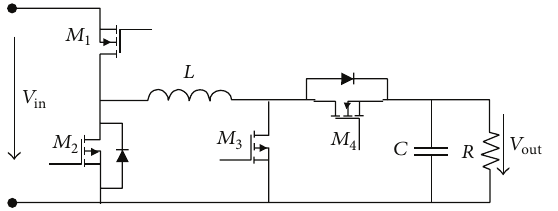
Figure 7: Noninverting buck-boost converter topology, Brey et al. [6].